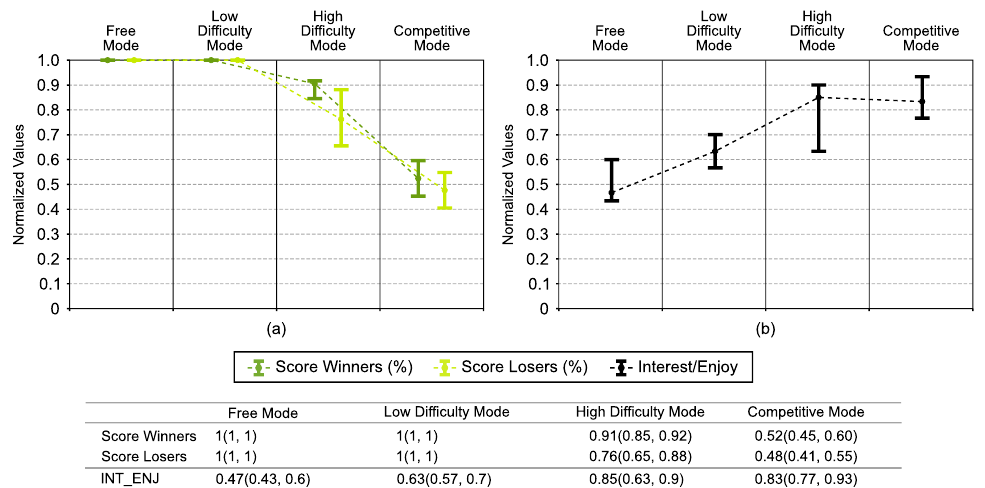
Figure 5. Representation of the parameters related to exercise performance. ( a ) Graphical representa- tion of the game score, divided between winners and losers of the competitive mode. ( b ) Graphical representation of the interest/enjoy parameter from the Intrinsic Motivation Inventory. All parame- ters were normalized by the min-max normalization method and are graphically represented in each game mode by the median value and an error bar representing the first and third quartiles. The table collects the normalized values of all parameters.